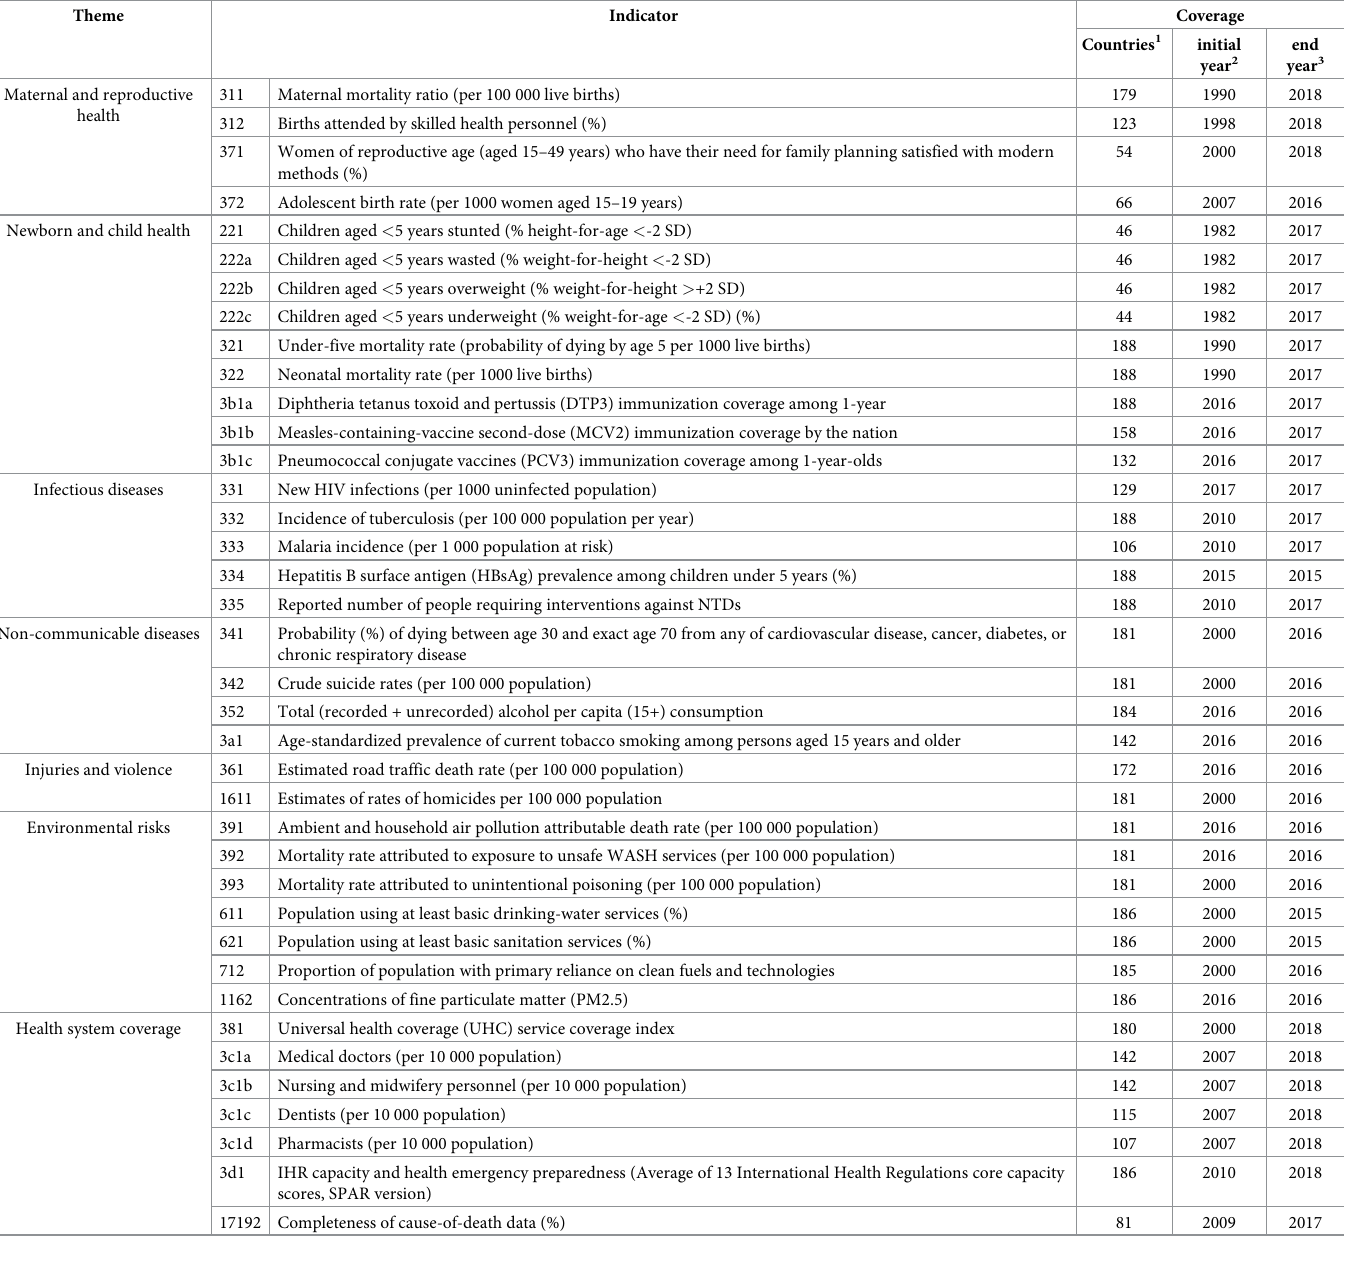
Table 1. WHO’ health-related indicators and global coverage: Summary data availability, by health theme.